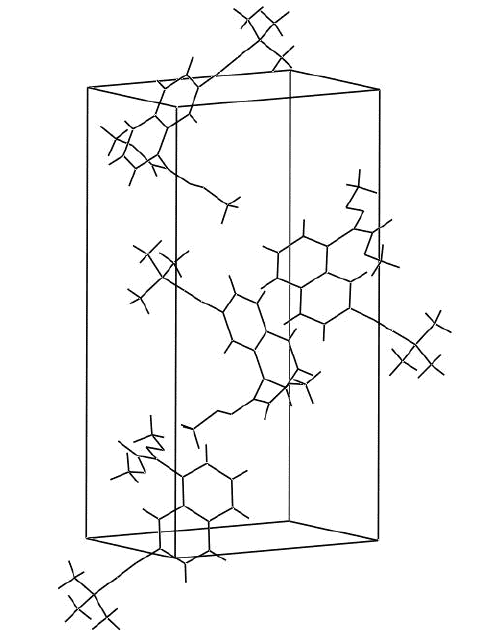
Figure 2. A perspective view of the crystal packing in the unit cell. Table 1. Selected bond distances (Å) by X-ray and theoretical